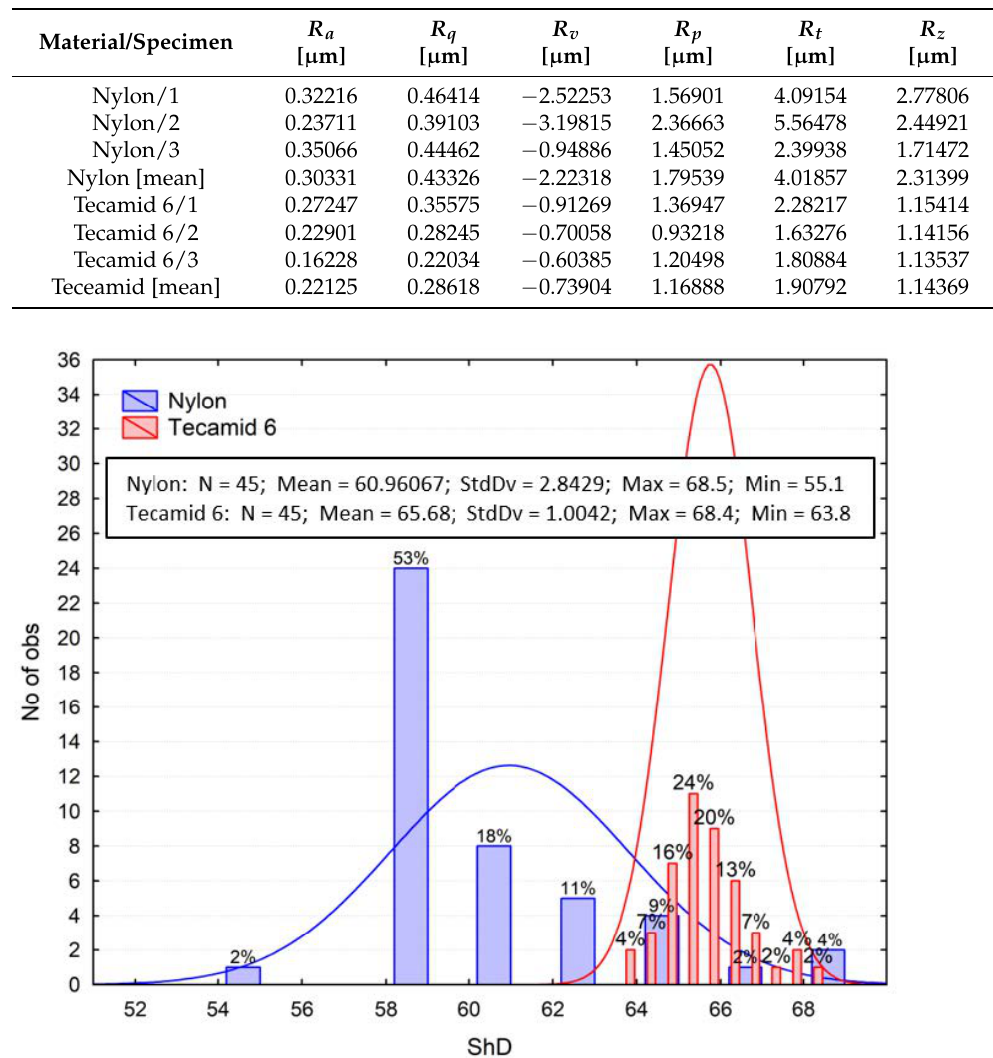
Table 3. Roughness values of tested polymers.